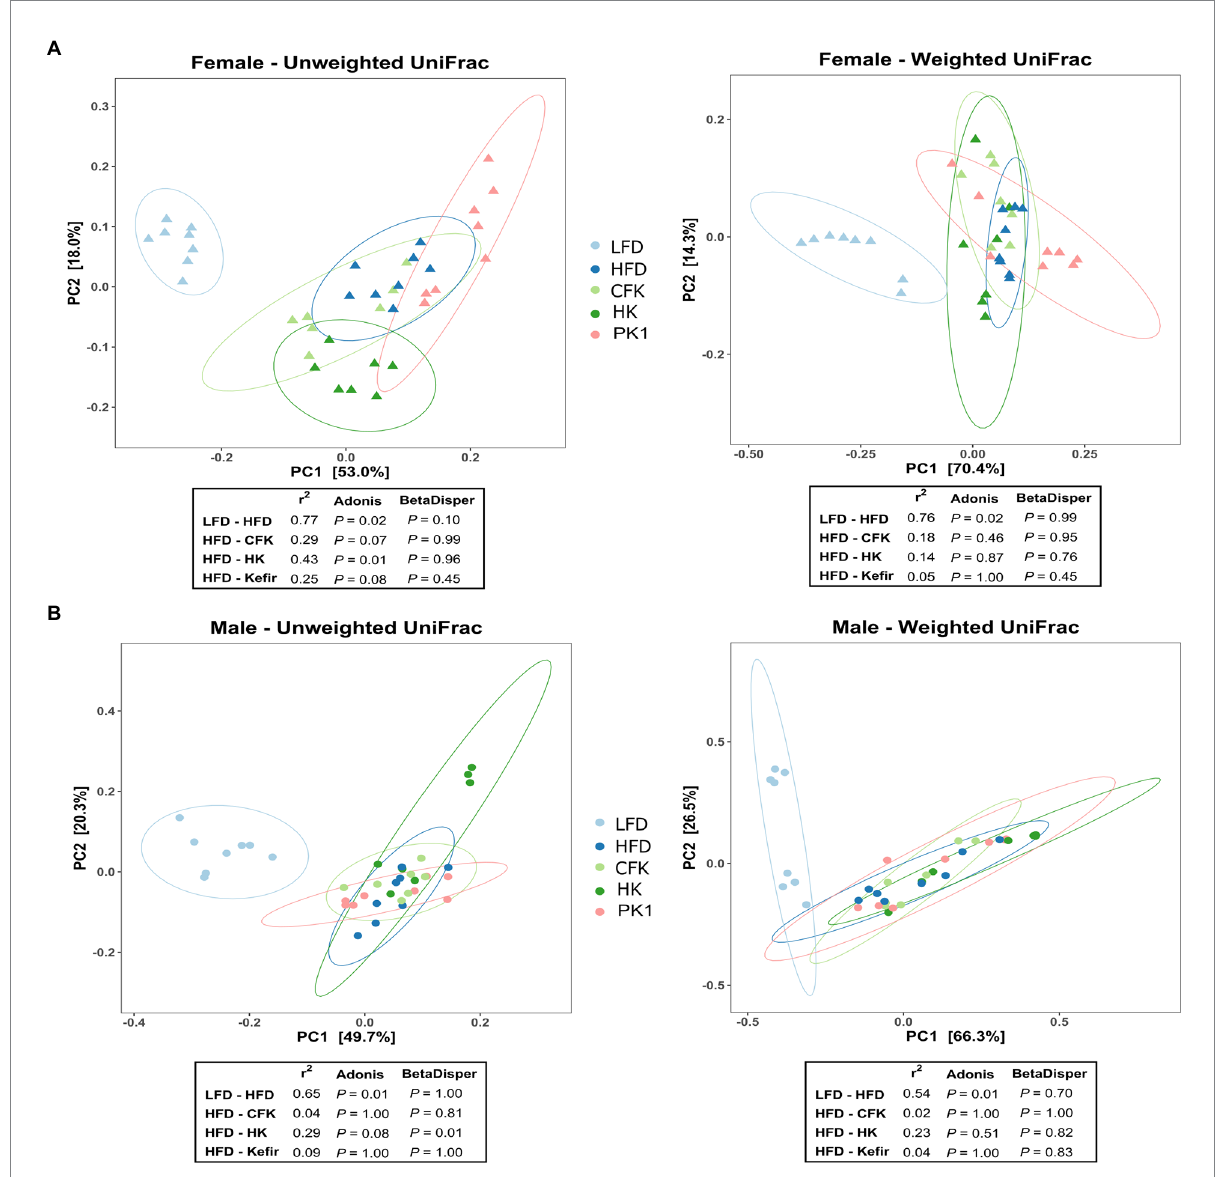
FIGURE 6 Principle coordinate analysis using unweighted and weighted UniFrac distance metric of the cecal microbiota of male/female C57Bl/6 mice fed a control diet or high-fat diet supplemented with milk or different kefir preparations for 8 weeks. A major shift between LFD and HFD groups was determined in both (A) female and (B) male mice with no difference between HFD and kefir consumption groups (CFK, HK and Kefir; n = 7–8). Means that do not share a letter are significantly different ( p < 0.05). LFD, mice fed a low fat diet supplemented with freeze-dried milk for 8 weeks; HFD, mice fed a high fat diet supplemented with freeze-dried milk for 8 weeks; PK1, mice fed a high fat diet supplemented with freeze-dried pitched kefir for 8 weeks; CFK, mice fed a high-fat diet supplemented with freeze-dried cell-free kefir; HK, mice fed a high-fat diet supplemented freeze-dried heat-treated